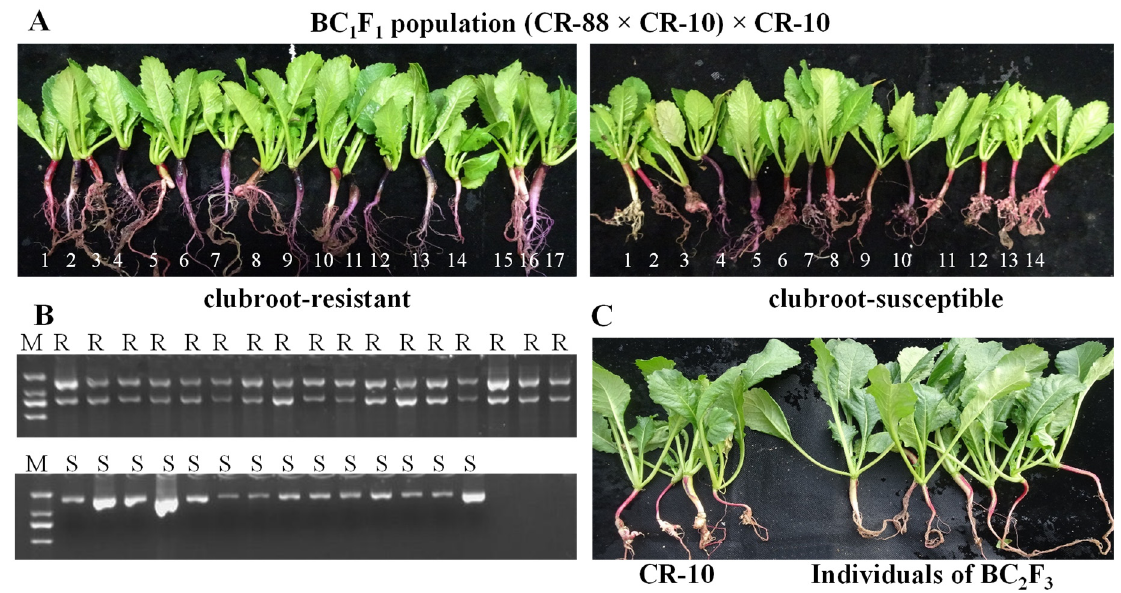
Figure 4. Validation of PCR markers using BC 1 F 1 populations derived from the crosses (CR-88 × CR-10) × CR-10. ( A ) Clubroot symptoms of individual plants at 60 days after first infection with P. brassicae . Seventeen immune or highly resistant individuals and fourteen of the most highly susceptible plants. ( B ) Results of PCR amplification. S and R indicate clubroot-susceptible and clubroot-resistant lines, respectively. M: DNA marker 2000 bp. ( C ) Clubroot symptoms of individuals derived from CR-10 and individuals of BC 2 F 3 .